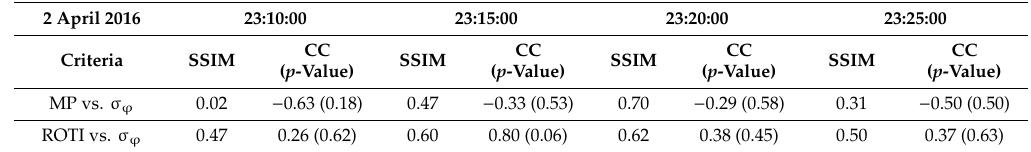
Table 22. SSIM and CC between the maps shown in Figure